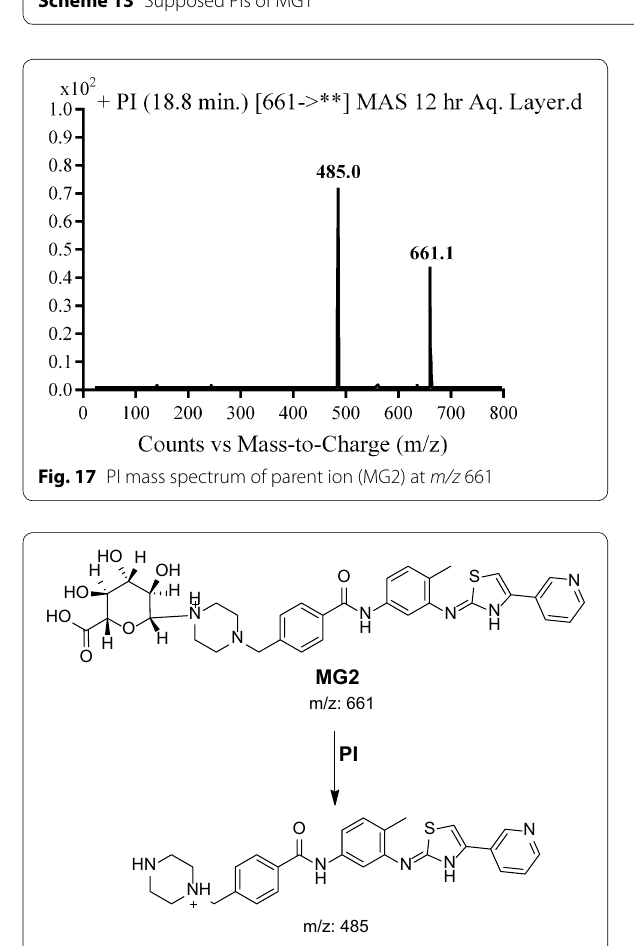
Fig. 19 PI mass spectrum of parent ion (MG4) at m/z